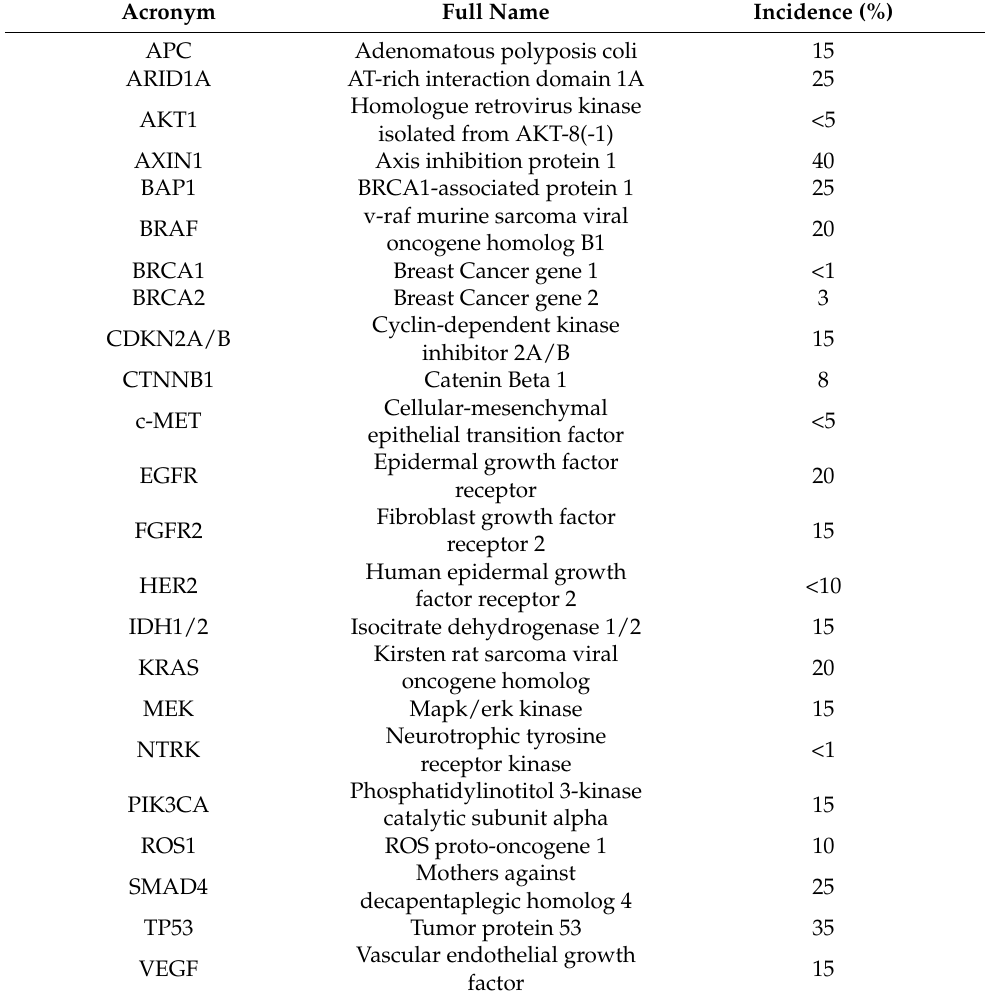
Table 1. Genetic landscape of